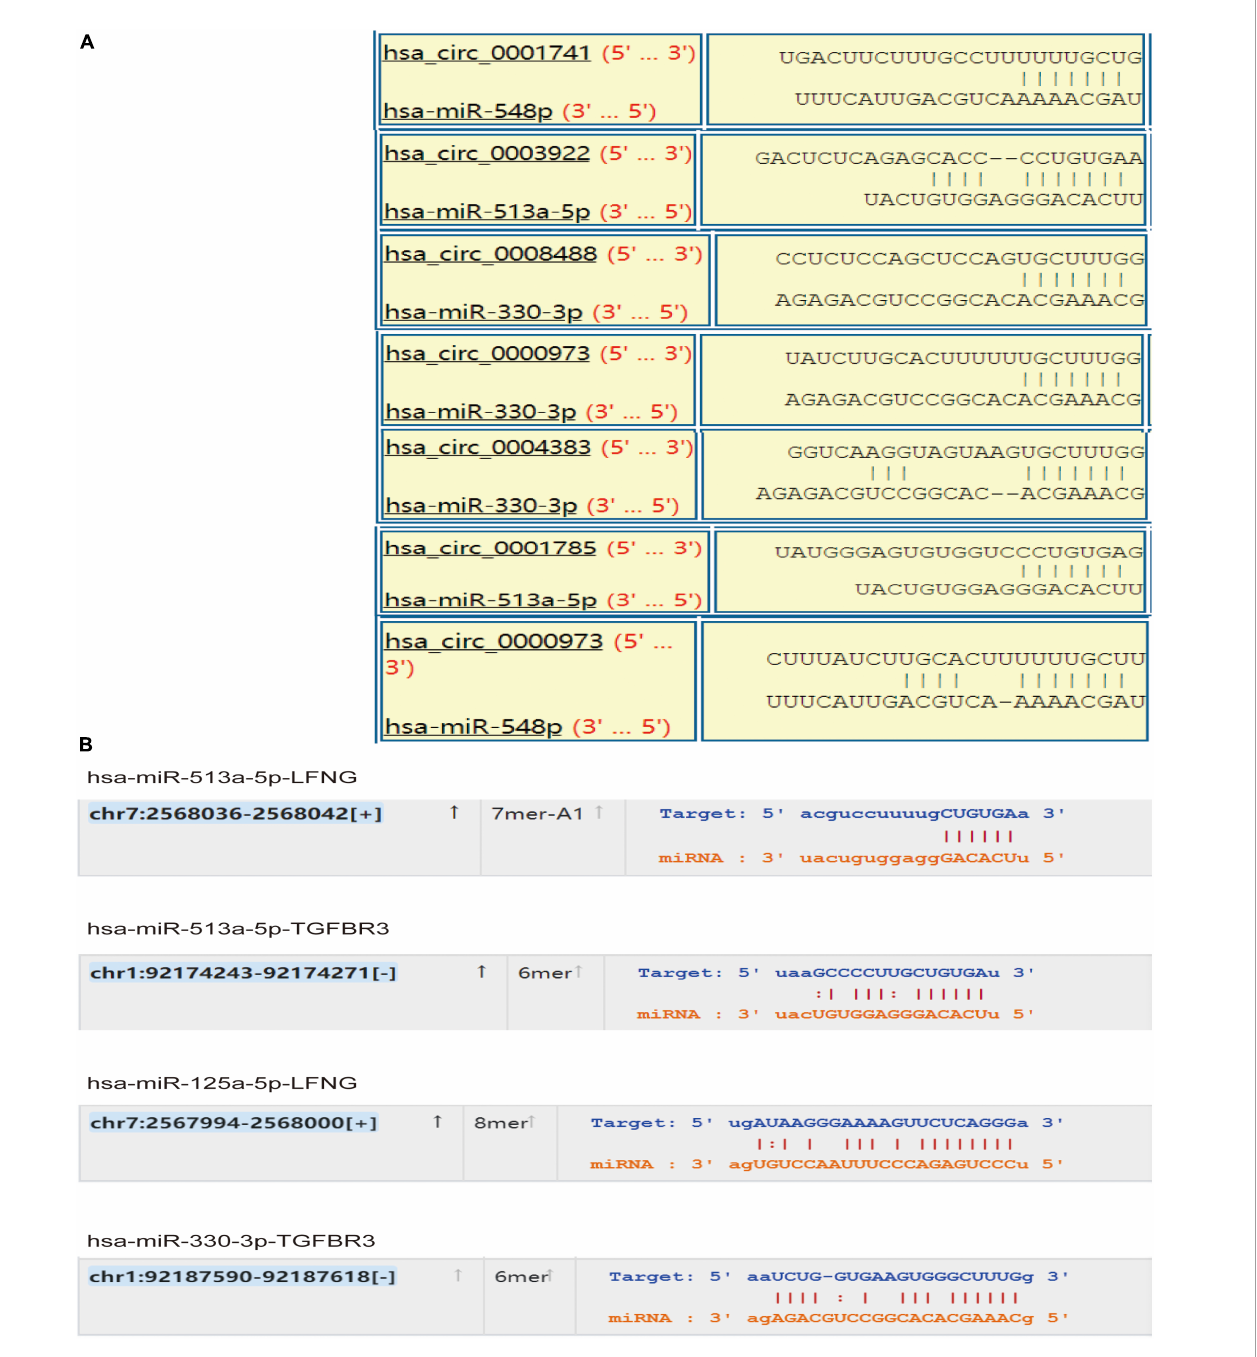
FIGURE5 Target prediction of circ-microRNA and micro-mRNA. To further corroborate the accuracy of the target of the ceRNA network, we predict the target location using bioinformatic analysis. (A) Binding target of circRNA and microRNA, and (B) predicted target binding site of microRNA and